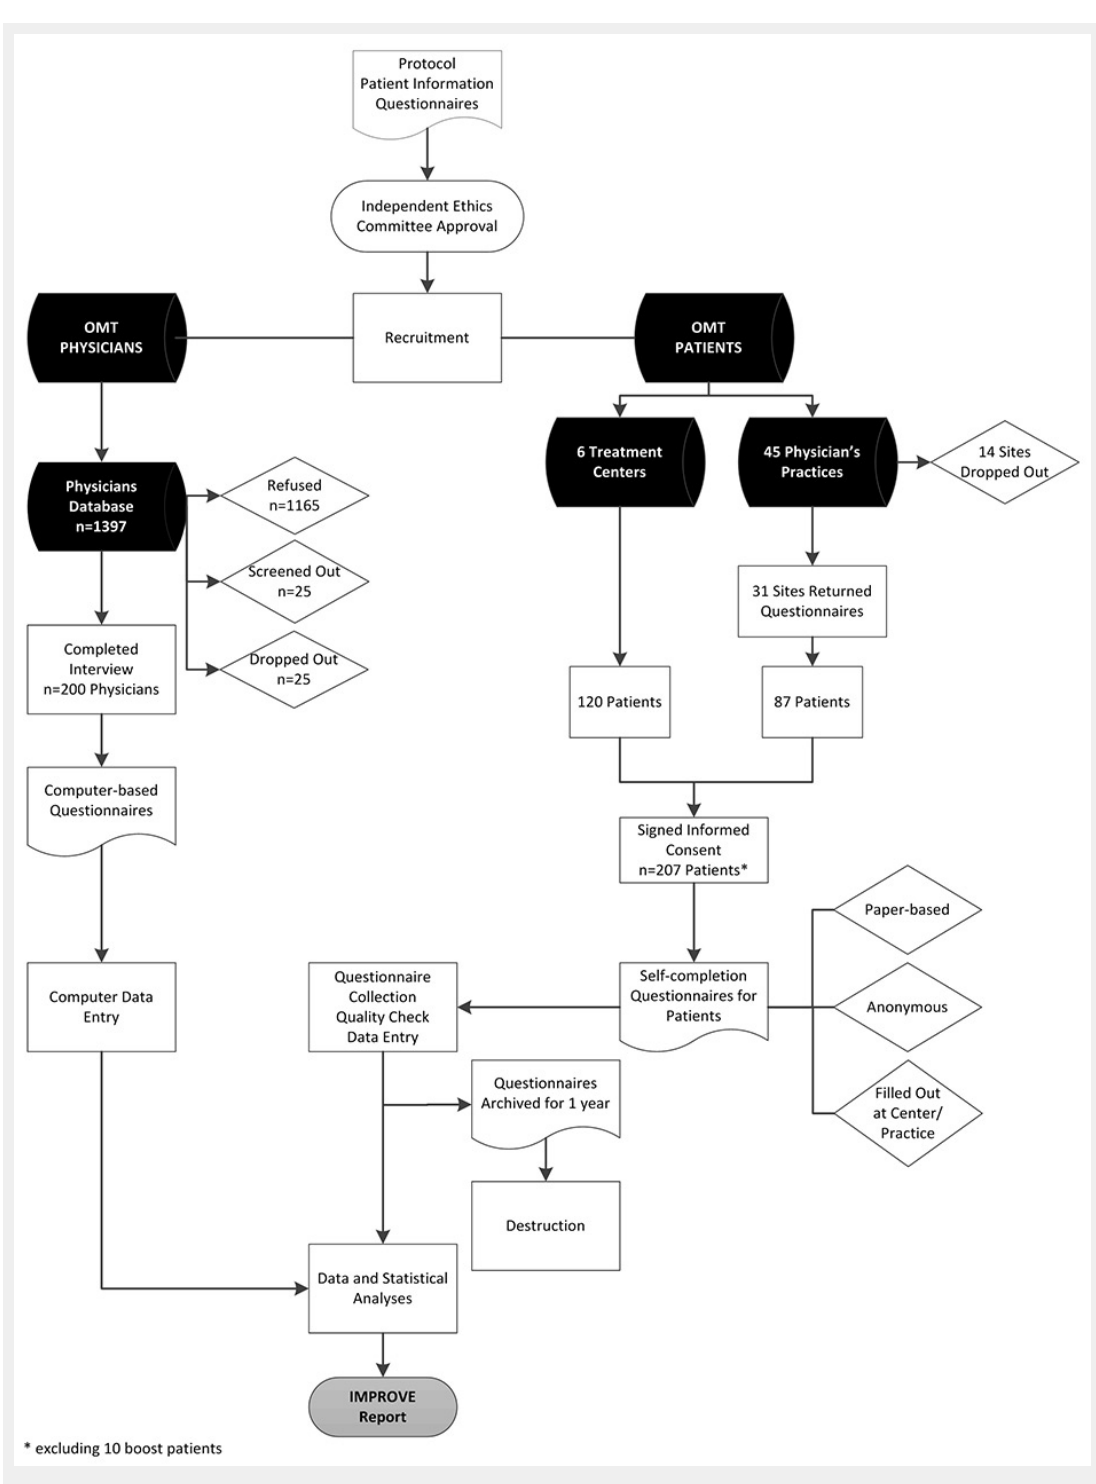
The Swiss IMPROVE study flow chart and disposition of subjects. OMT = opioid maintenance